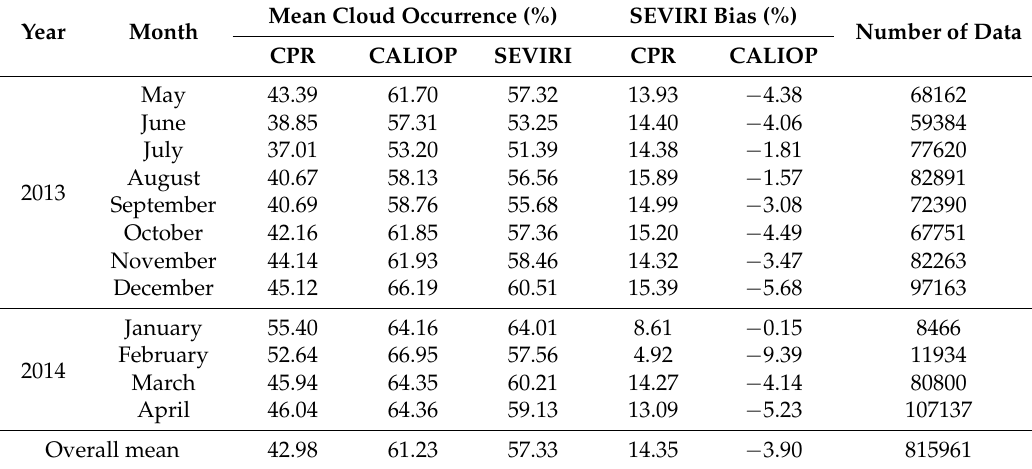
Table 2. Summary of cloud occurrence frequencies over all matchup cases per month among Cloud Profiling Radar (CPR), Cloud-Aerosol LiDAR with Orthogonal Polarization (CALIOP), and Spinning Enhanced Visible and Infrared Imager (SEVIRI). All results are given in cloud occurrence frequency units